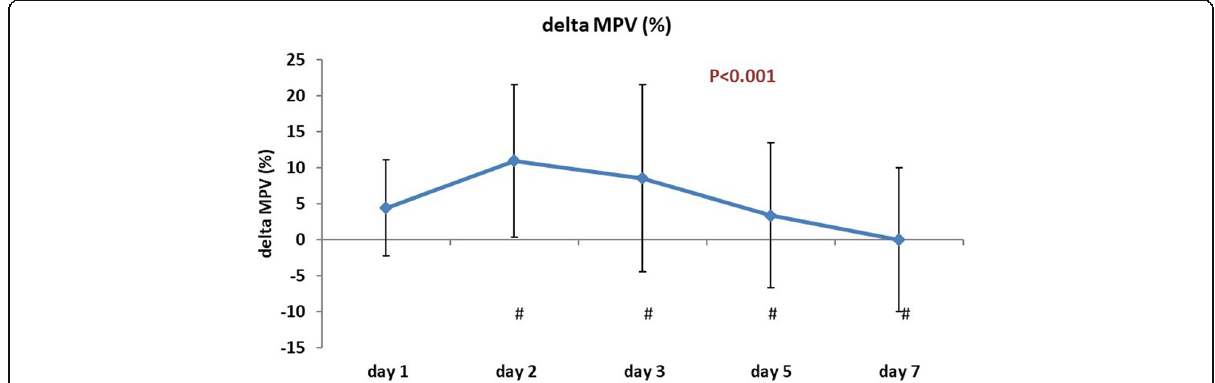
Fig. 3 Delta MPV during 1st week of ICU stay. Data presented as means; error bars represent standard deviation. p < 0.001 = highly significant. The number sign (#) indicates highly significant difference compared to day 1 delta MPV value